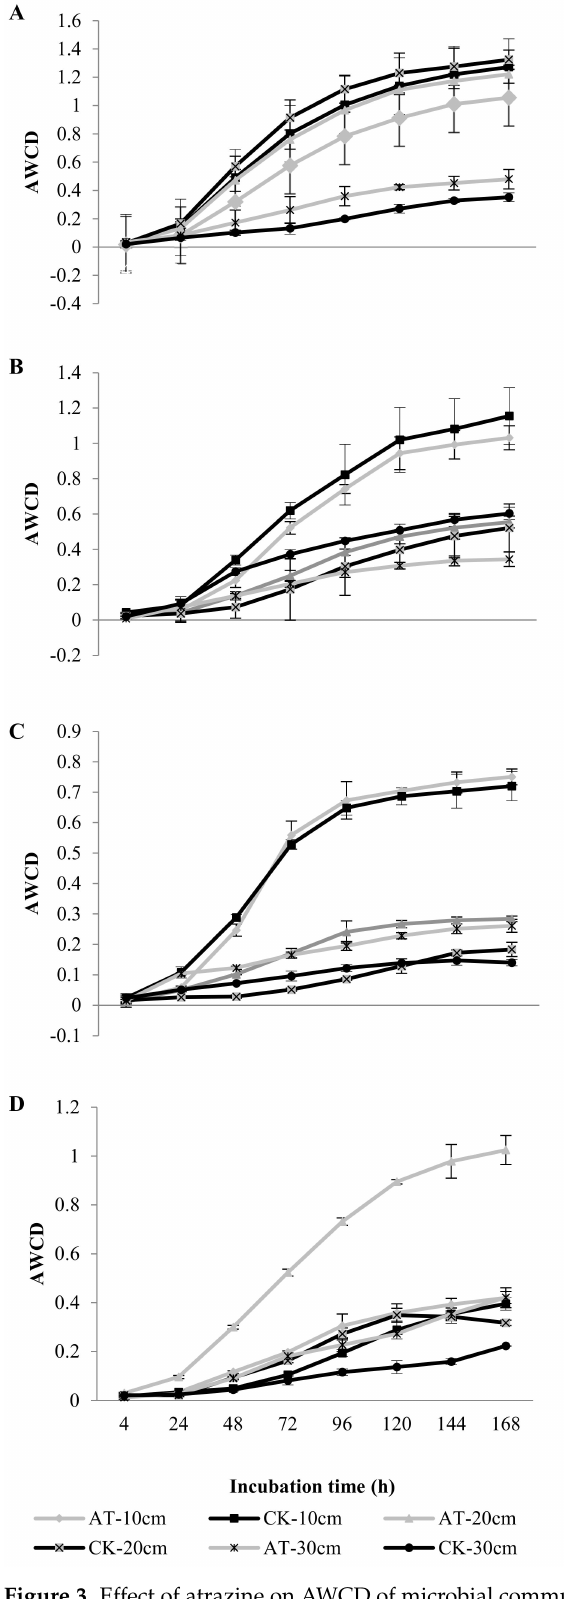
Figure 3. Effect of atrazine on AWCD of microbial community in cultivated soil layers of chernozem. Each value represents mean ± SD ( n = 3). ( A ) 1 d, ( B ) 7 d, ( C ) 21 d, and ( D ) 119